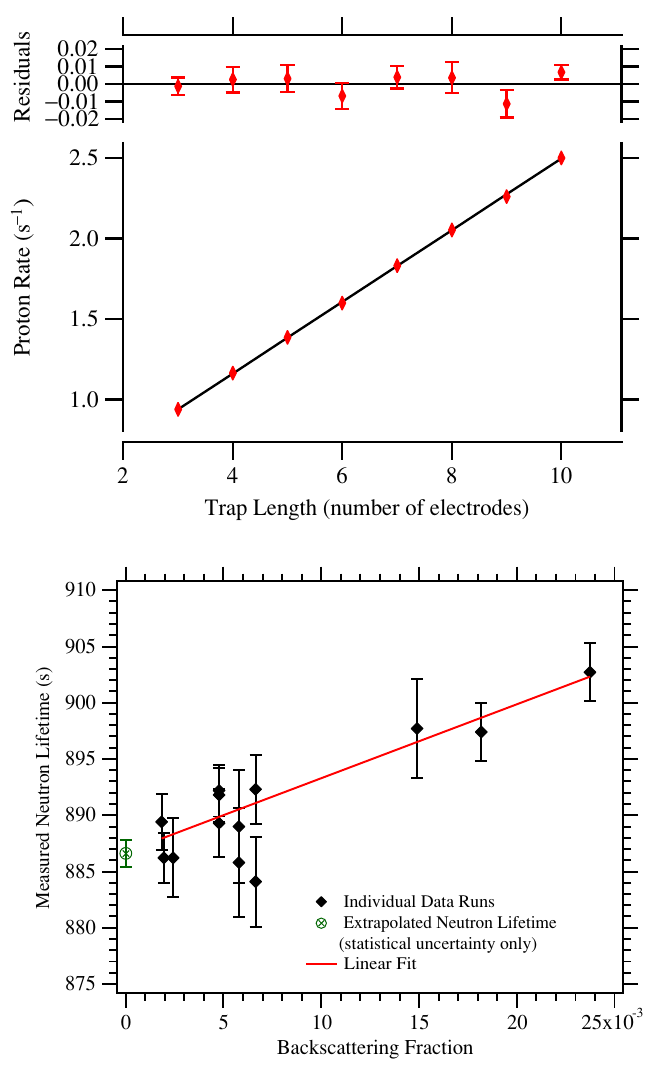
Figure 3. ( Top ): Data from the 2005 NIST beam neutron lifetime experiment [25], showing the proton count rate vs. trap length. ( Bottom ): Measured neutron lifetimes using different detectors and FIG. 20. (Color online) A linear fit of the measured neutron acceleration potentials vs. backscatter probability. The corrected neutron lifetime is found by linear lifetime versus the detector backscattering fraction f Bsc . The extrap- TABLE IV. Results from the fit of proton-to-neutron counts versus trap length for the series used in the determination of the neutron olation to zero backscattering gives the free neutron lifetime. The extrapolation to zero lifetime. Column 2 contains the measured lifetime; in column 3 a small correction has been made for lost protons (see Sec. IV D); column 4 contains the 1- σ statistical uncertainty; column 5 contains the proton-neutron ratio at zero trap length (the intercept); column 6 contains its uncertainty; column 7 gives the reduced χ 2 for the fit; and column 8 gives the probability of getting a larger reduced χ 2 . Series